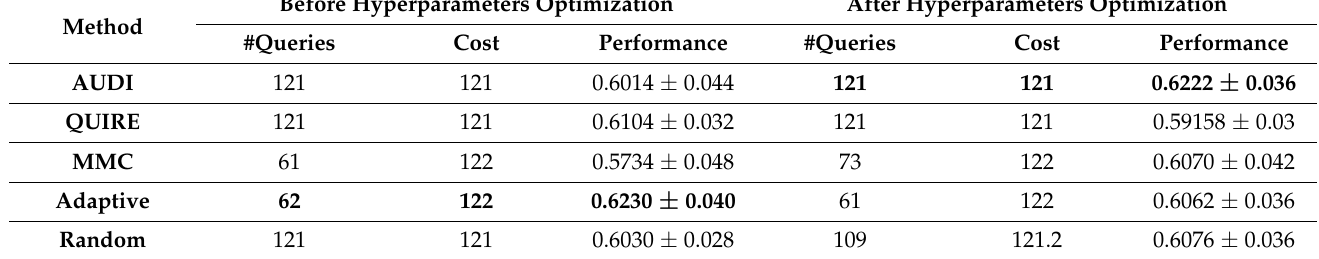
Figure 6. Classification accuracy for the five selection AL strategies with grid search optimizer. Table 7. Comparative Evaluation of Active learning Selection Methods in terms of F-Score (the best values are